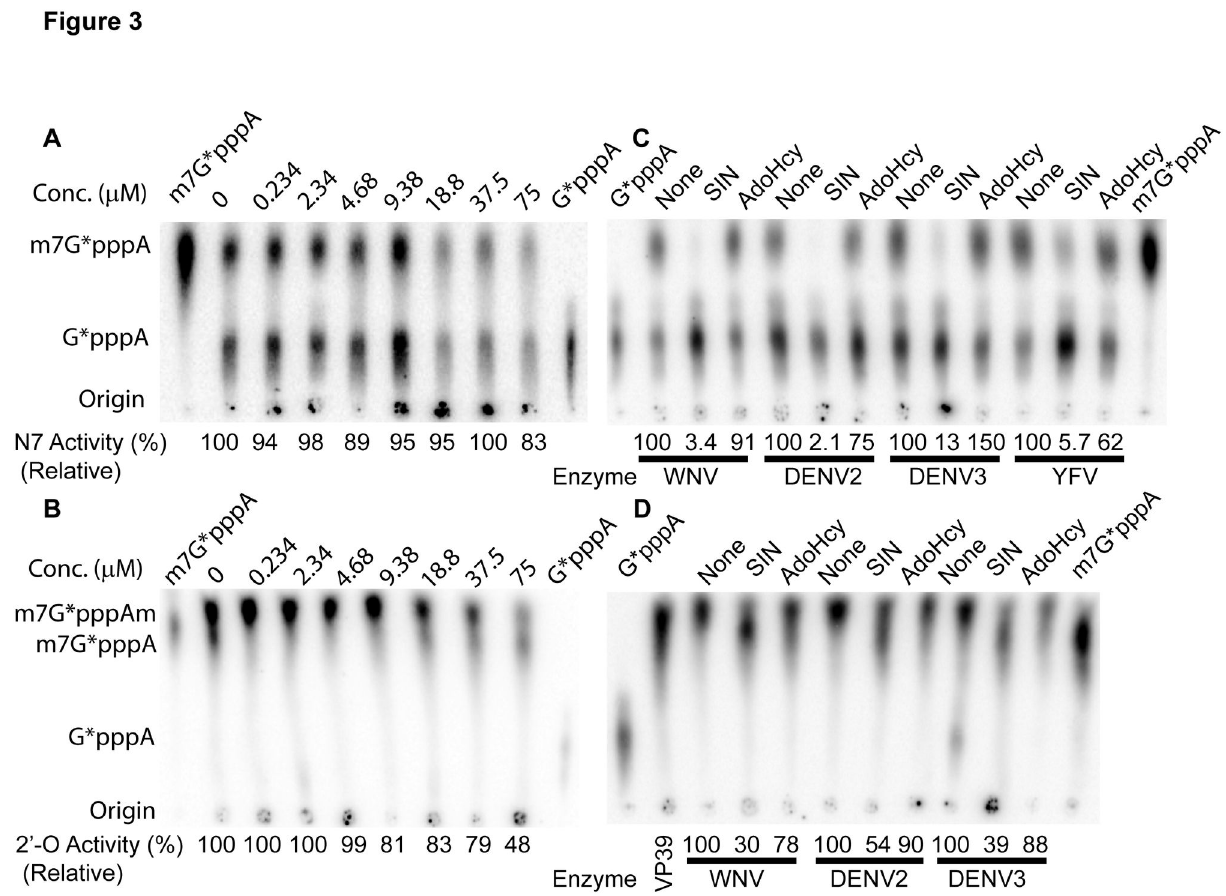
Figure 3. Inhibition of the N-7 and 2’-O methylation activities of the flavivirus MTases by AdoHcy. ( A ) TLC analysis of inhibition of the N-7 methylation activity of the WNV MTase by AdoHcy was analyzed on TLC plates. The spots representing different cap structures on TLC plates were quantified by a PhosphorImager. The N-7 methylation was measured by conversion of G*pppA-RNA→m 7 G*pppA-RNA (e.g., the specific activity (%) = Intensity (m 7 G*pppA)/(Intensity (G*pppA) +Intensity (m 7 G*pppA)) *100) (Here and after, the asterisk indicates that the following phosphate is 32 P labeled; the RNA represents the first 90 nucleotides of the WNV genome). The relative methylation activity without AdoHcy was set at 100%, and the relative methylation activity with a particular compound was defined as specific activity (compound)/specific activity (no compound) * 100. ( B ) TLC analysis of inhibition of the 2’-O methylation activity of the WNV MTase by AdoHcy. The 2’-O methylation was measured by conversion of m 7 G*pppA-RNA→m 7 G*pppAm-RNA (e.g., the specific activity (%) = Intensity (m 7 G*pppAm)/(Intensity (m 7 G*pppA) +Intensity (m 7 G*pppAm)) *100). The methylation activity without AdoHcy was set at 100%, and the relative 2’-O methylation activity with compounds was defined the same way as in panel A. The migration positions of the G*pppA and m 7 G*pppA molecules are labeled on the side of the TLC images. ( C - D ) TLC analysis of inhibition of the N-7 ( C ) and 2’-O ( D ) methylation activities of flavivirus MTases in the presence or absence of 150 µM SIN or 150 µM AdoHcy. The methylation activity for each MTase without compound was set at 100%. The relative methylation activity for each MTase with compound (SIN or AdoHcy) was calculated as percentage to the activity without any compound. The migration positions of the G*pppA, m 7 G*pppA, and m 7 G*pppAm molecules are labeled on the side of the TLC images. VP39 was included in Panel D as a positional control for the 2’-O methylation reaction.